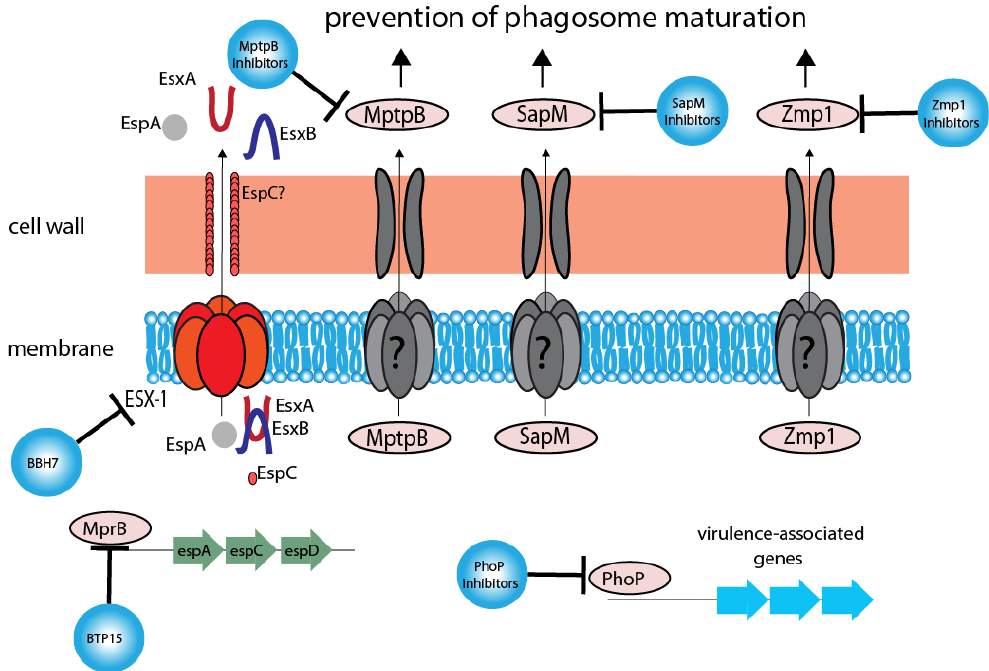
Figure 1. Schematic overview of antivirulence targets in M. tuberculosis .